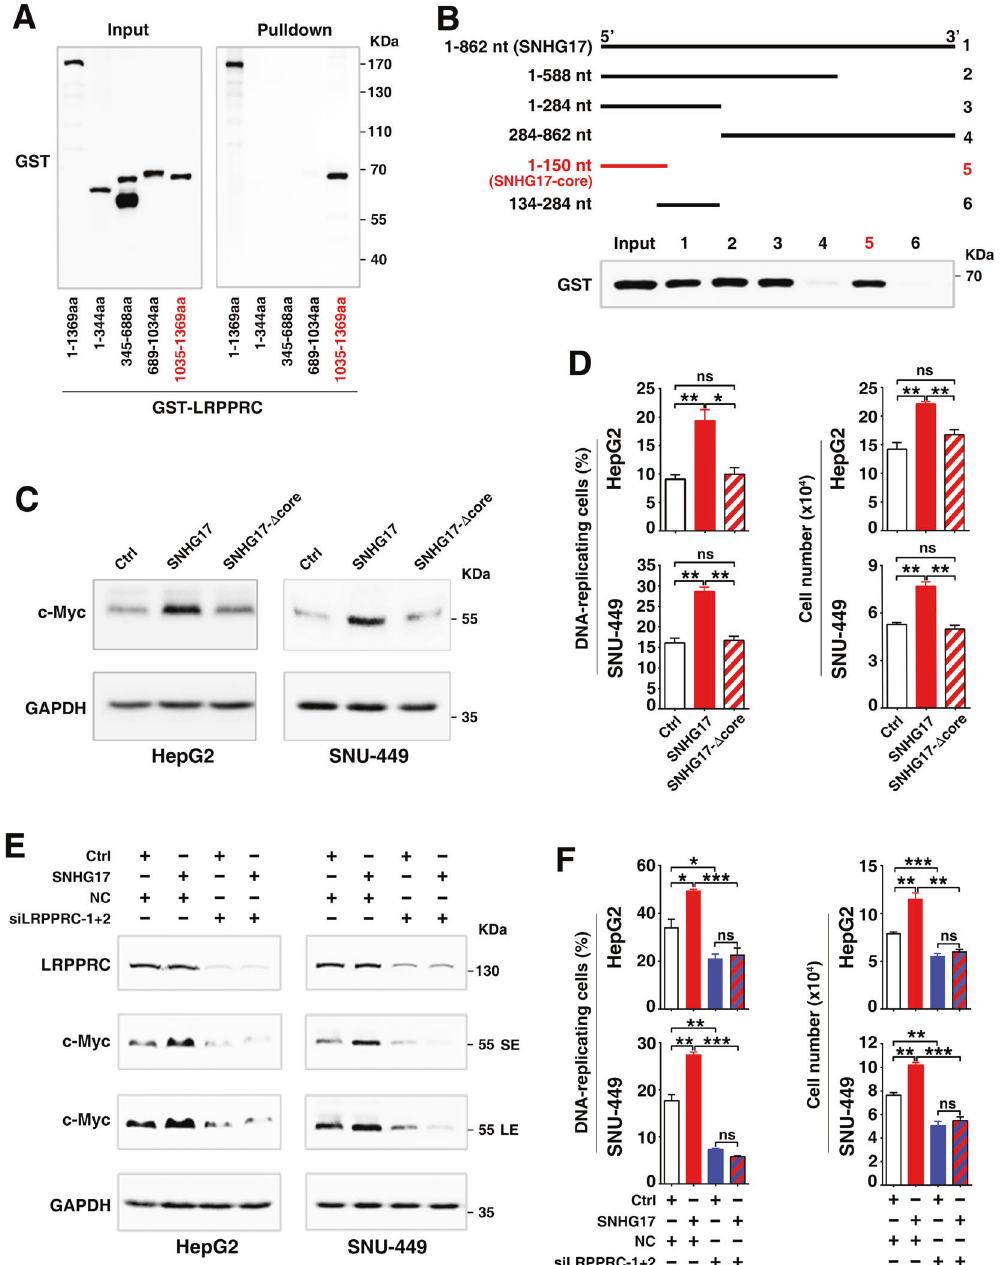
Fig. 6 SNHG17 increases c-Myc level and promotes G1/S transition via interacting with LRPPRC. A SNHG17 was associated with the 1035 – 1369-aa domain of LRPPRC. Biotin-labeled SNHG17 was incubated with GST-tagged full-length or truncated LRPPRC, then pulled down by streptavidin-beads, and the retrieved proteins were detected by Western blotting. B The 1 – 150-nt fragment of SNHG17 bound to the 1035 – 1369-aa domain of LRPPRC. Biotin-labeled full-length or truncated SNHG17 was incubated with the GST-tagged 1035 – 1369-aa of LRPPRC, then pulled down by streptavidin-beads, and the retrieved proteins were detected by Western blotting. C – D Deletion in the 1 – 150-nt of SNHG17 attenuated the roles of SNHG17 in increasing c-Myc protein level, DNA-replicating cells, and cell growth. Cells stably expressing SNHG17 or 1 – 150-nt-deleted mutant (SNHG17- Δ core) and the control cells (Ctrl) were subjected to Western blotting ( C ), EdU incorporation assays ( D , left panel), or cell counting ( D , right panel). E – F Silencing LRPPRC abrogated the roles of SNHG17 in increasing c-Myc level, DNA-replicating cells, and cell growth. Cells stably expressing SNHG17 and the control cells (Ctrl) were transfected with NC or siLRPPRC, then subjected to Western blotting ( E ), EdU incorporation assays ( F , left panel) or cell counting ( F , right panel). SE, short exposure; LE, long exposure. For D and F , error bars represent mean ±SEM from three independent experiments. P values were assessed by unpaired Student ’ s t test. *, P < 0.05; ** , P <0.01; ***, P <0.001; ns , not signi fi Rapid ampli fi cation of cDNA ends (RACE) Total RNA of SF cells was used to amplify 5 ′ - and 3 ′ -ends of SNHG17. The 5 ′ - end was determined using a 5 ′ -Full RACE Kit (D315, TaKaRa, Kyoto, Japan). 3 ′ RACE was performed as described previously [45]. The PCR-ampli fi ed sequences of 5 ′ - and 3 ′ -end fragments were determined by direct sequencing.